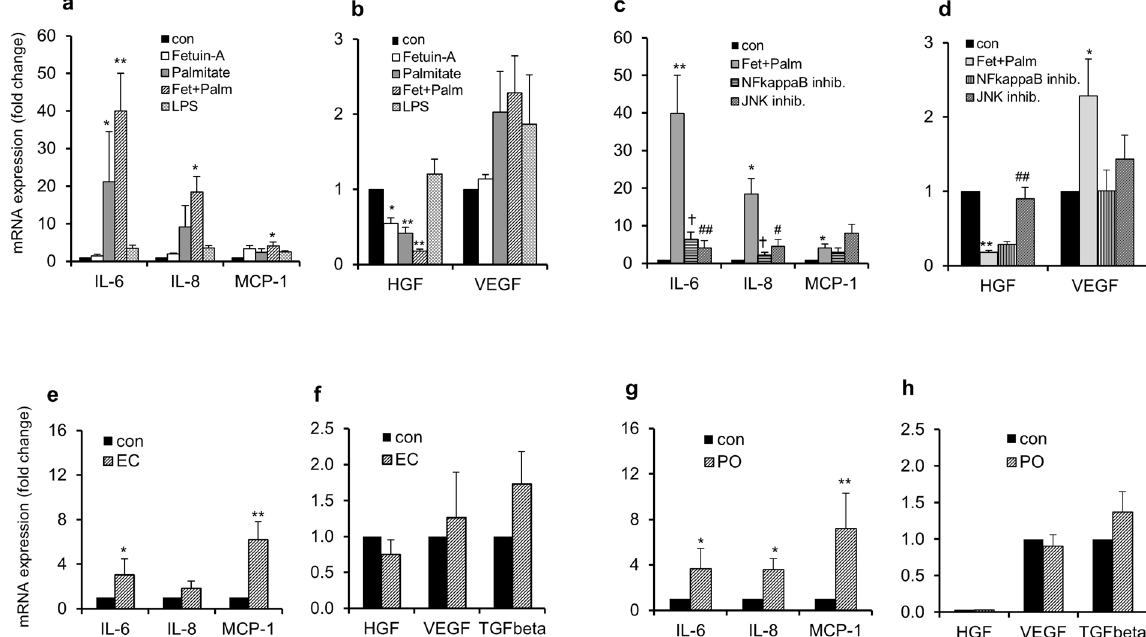
Figure 3. Influence of fetuin-A and/or palmitate on RSFC. Effect of 600 µ g/ml fetuin-A ± 50 µ mol/l palmitate, palmitate per se, and LPS (as endotoxin control) on the mRNA-expression of ( a ) the (pro)-inflammatory proteins IL-6, IL-8 and MCP-1, and ( b ) the regenerative factors HGF and VEGF 24 h after treatment of RSFC. ( c,d ) Treatment of RSFC with an NFkappaB inhibitor or JNK inhibitor. Statistical analysis: ANOVA and Tukey post hoc test. Values are mean ± SEM from three independent experiments ( * p < 0.05 and ** p < 0.01 for fetuin-A and/or palmitate-treated cells versus controls (con) defined as 1 as well as # p < 0.05 and ## p < 0.01 or † < 0.05 and †† < 0.01 for fetuin-A/palmitate-treated cultures versus identical cultures pretreated with the respective inhibitors). Effects of fetuin-A-treated RSFC on the mRNA-expression of (pro)-inflammatory and regenerative factors in cocultured EC and PO. Cocultures of RSFC with EC or PO were treated with fetuin-A (600 µ g/ml) for 24 h. The mRNA-expression of (pro)-inflammatory factors ( e , g ) and regenerative factors ( f , h ) in EC and PO, respectively, is shown. Statistical analysis: paired t-test to analyze differences in measurement pairs from the same donors. Values are mean ± SEM from four independent experiments ( * p < 0.05 and ** p < 0.01 for cocultures treated with fetuin-A versus controls (con) defined as